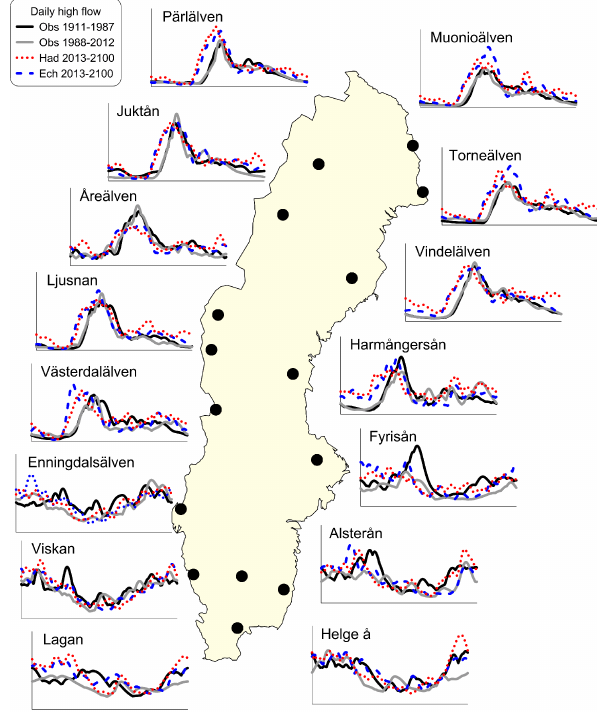
lected catchments across Sweden obtained using a 1-month Gauss filter for observed and projected time series. Note: magnitudes of observed and projected values are not comparable; only the timing of high flows should be compared. Solid lines represent observa- tions (Obs) for different time periods. Dotted and dashed lines rep- resent S-HYPE modeling with forcing data from the Hadley (Had) and Echam (Ech) climate models,